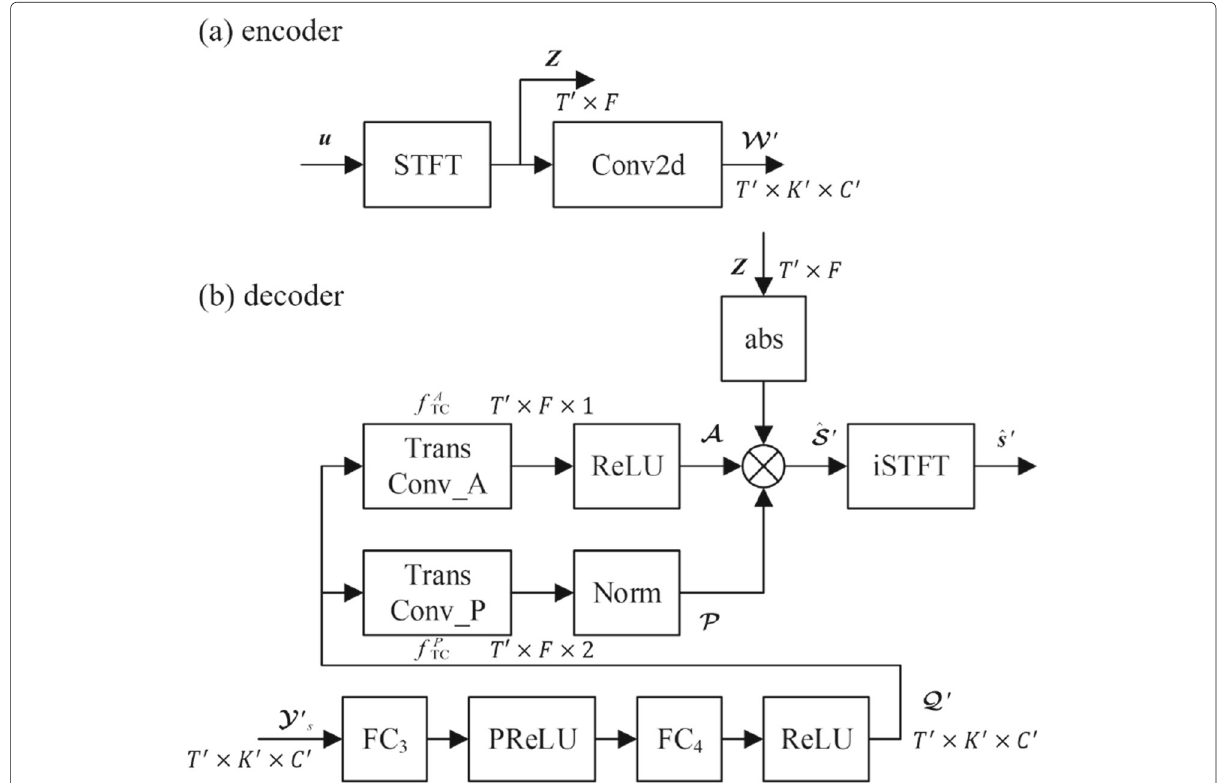
Fig. 4 The structure of the encoder and the decoder in the TF-domain